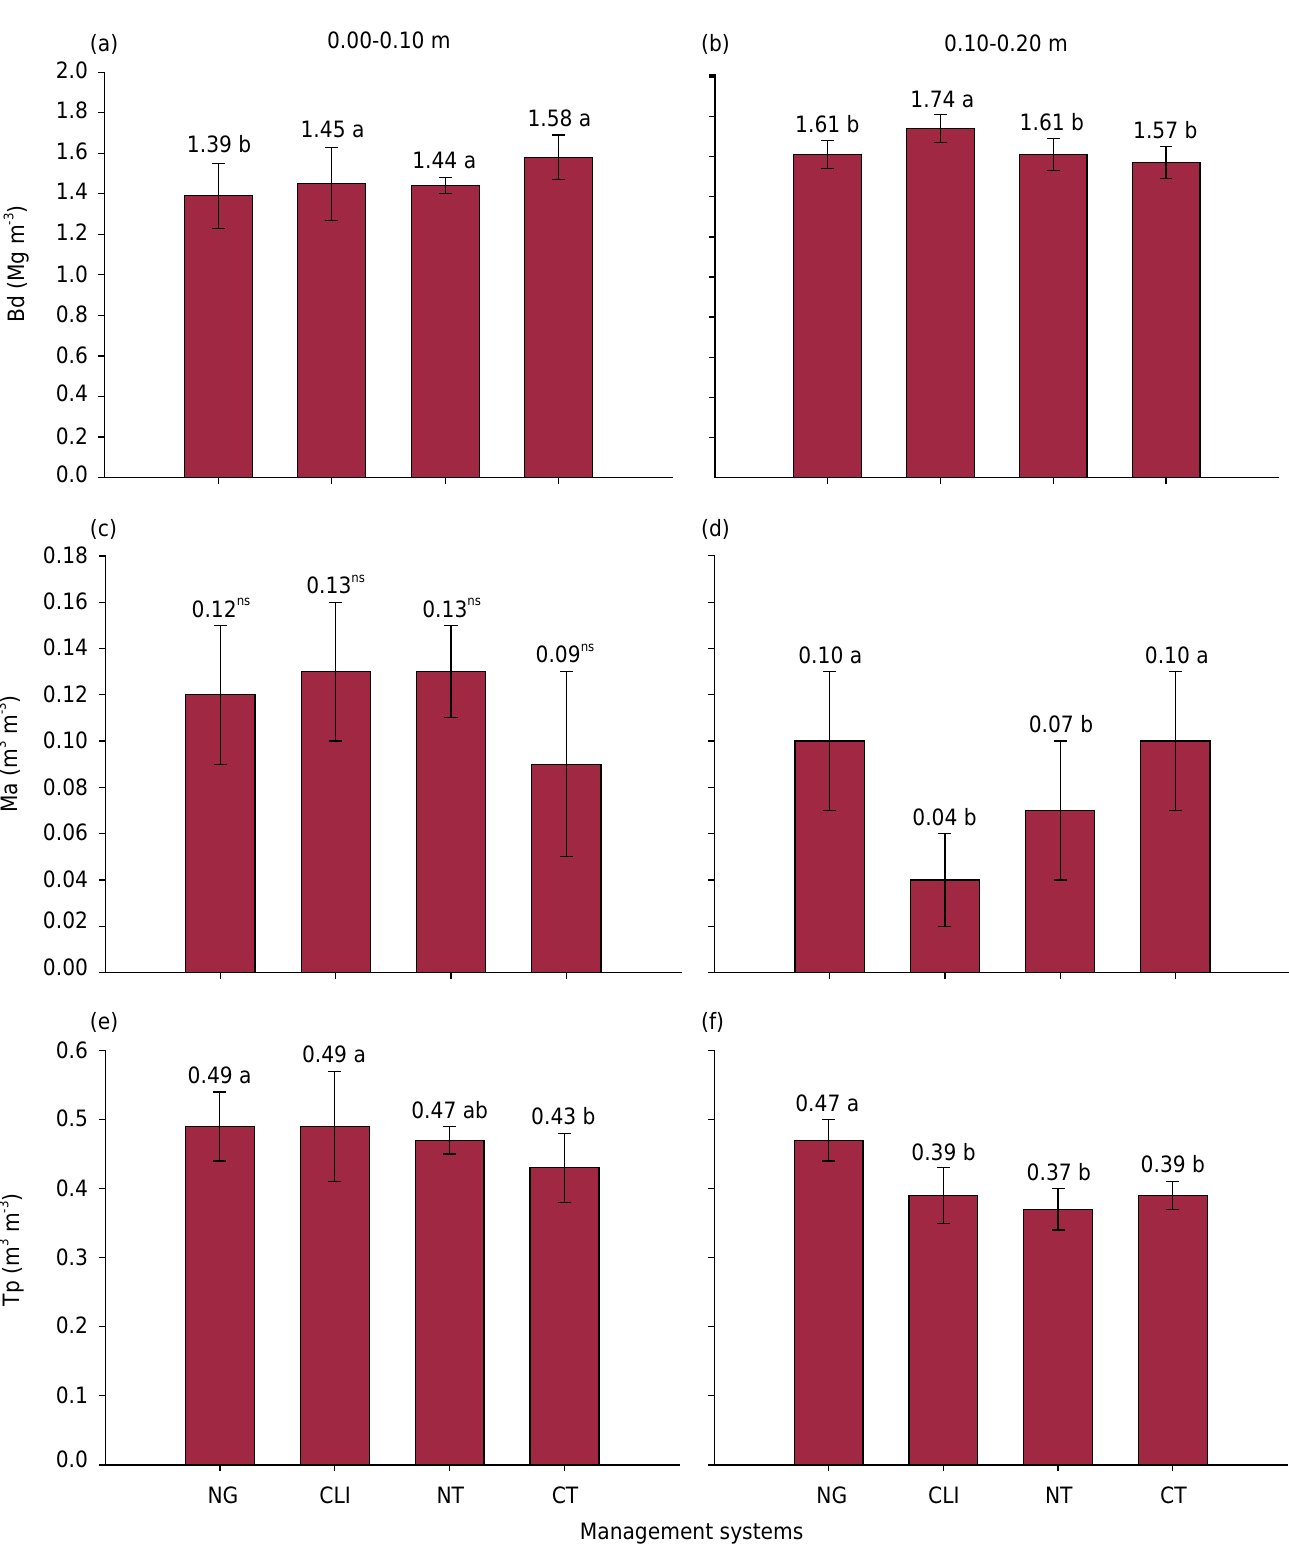
Figure 3. Bulk density (Bd) (a, b), macroporosity (Ma) (c, d), and total porosity (Tp) (e, f) of an Albaqualf under different management systems in the 0.00-0.10 and 0.10-0.20 m layers. NG: native grassland; CLI: crop-livestock integration; NT: no-tillage; CT: conventional tillage. Means followed by the same letter in a column, within each variable and soil layer, were not significantly different from each other by the Duncan test at 5 %. Vertical bars indicate the standard